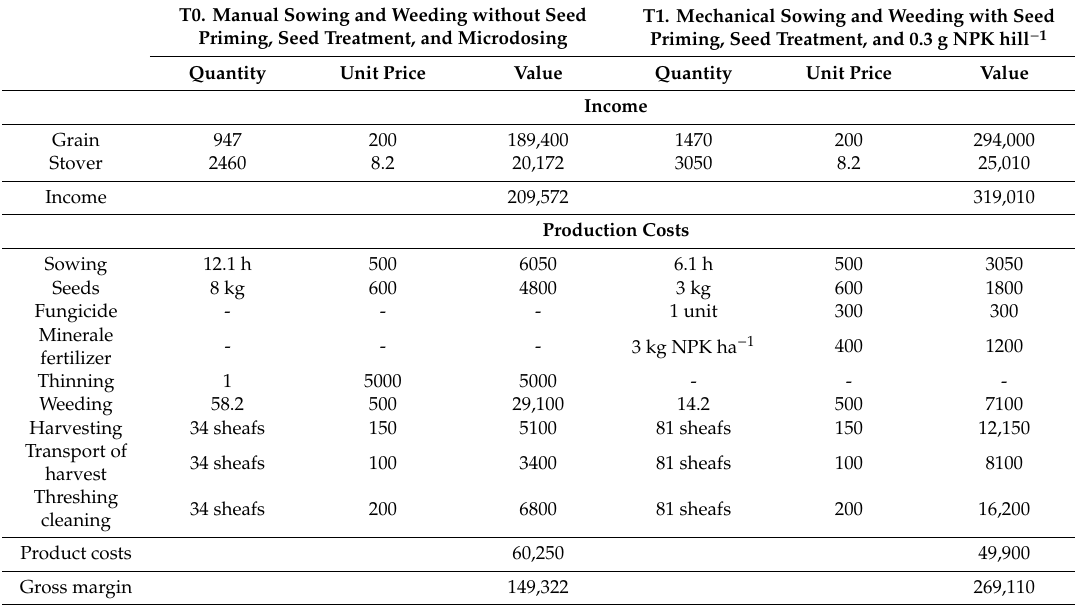
Table 4. E ff ect of the treatments on income, production cost, and gross